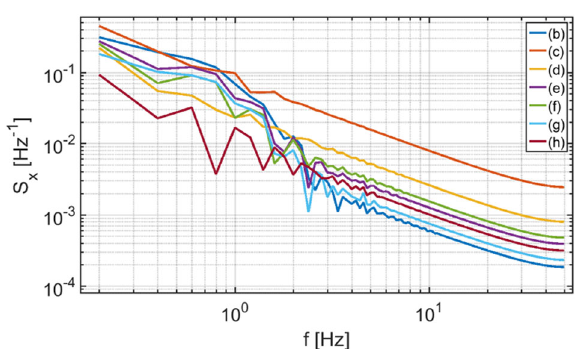
Fig. 8 Current noise PSD focused on the low-frequency regime that corresponds with fl icker noise. Models ( b – h ) in the legend coincide with the order presented in Fig. 3.